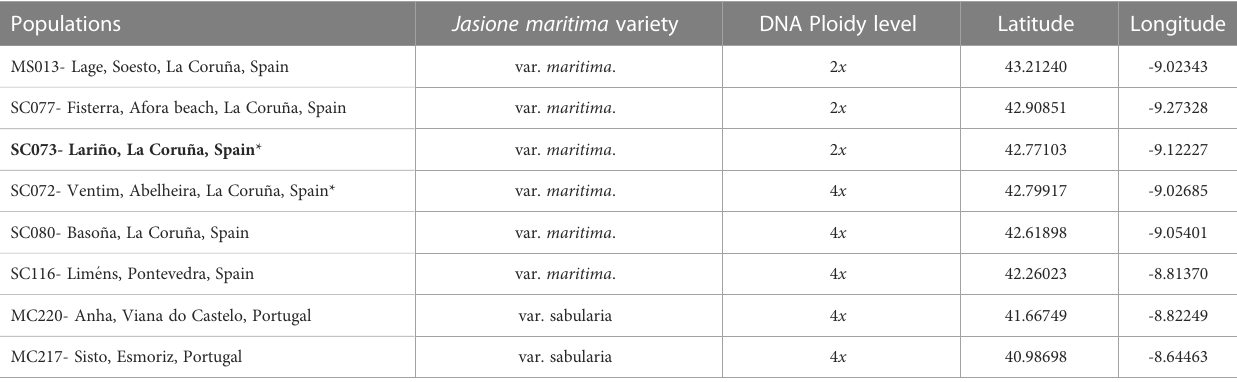
TABLE 1 Location and DNA ploidy level (2 x -diploid, 4 x -tetraploid) of the natural Jasione maritima populations. Populations Jasione maritima variety DNA Ploidy level Latitude